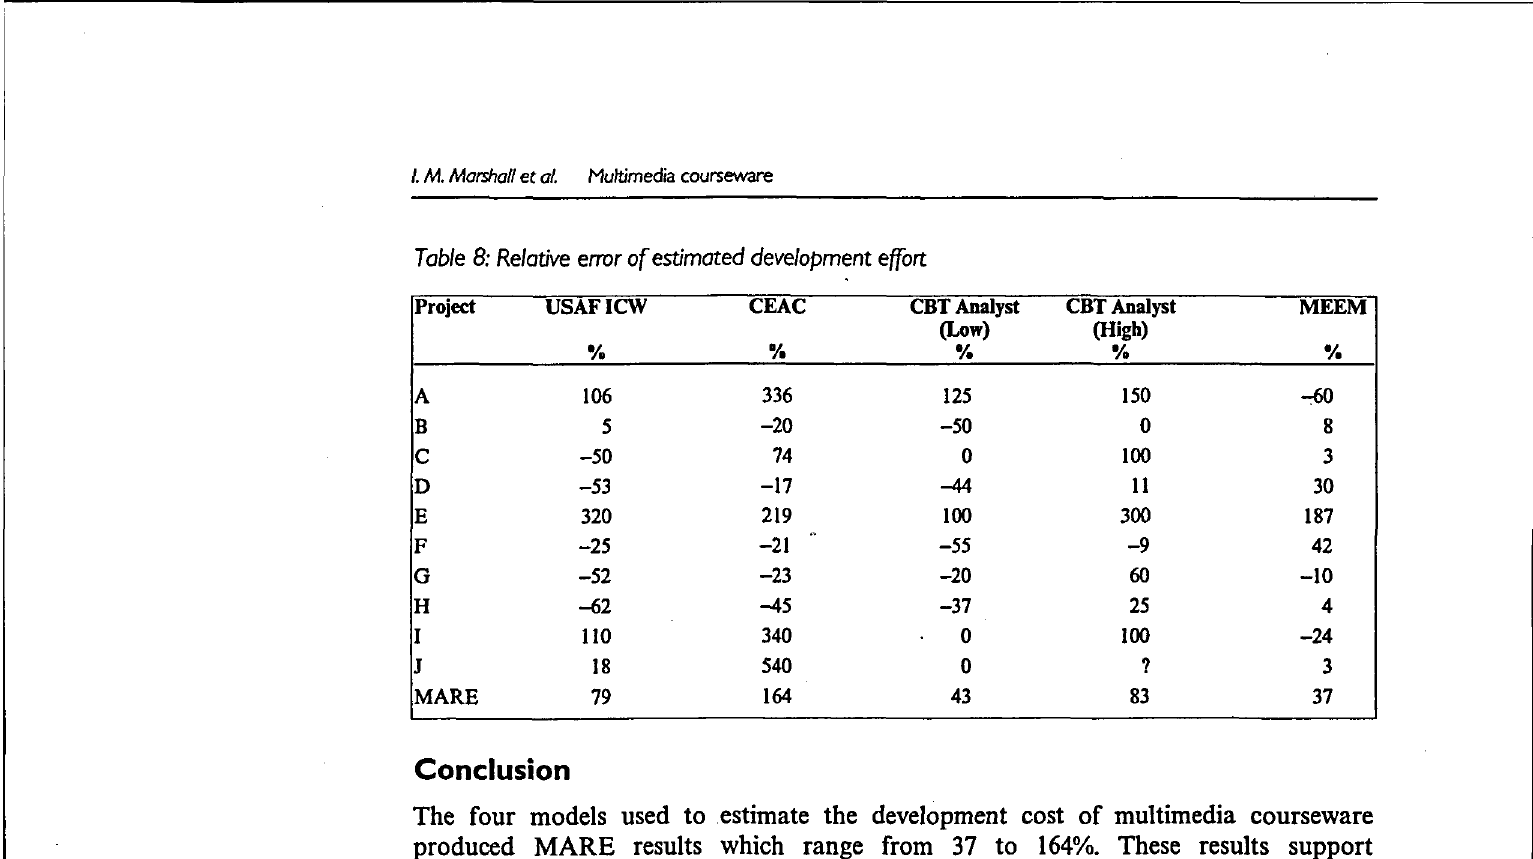
Table 8: Relative error of estimated development